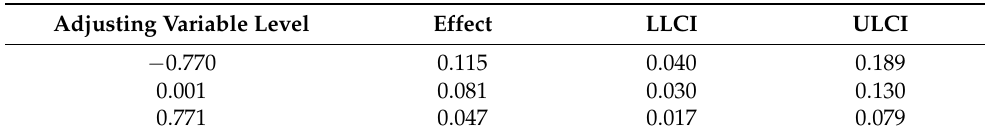
Table 8. Results from moderated mediating